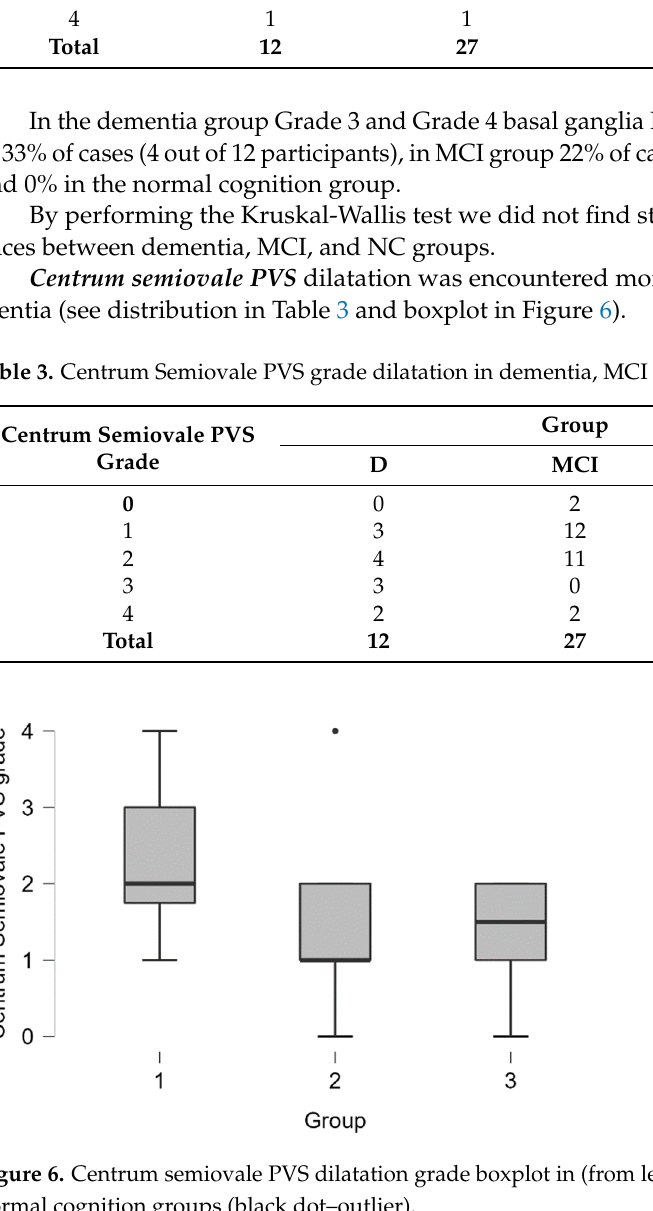
Table 4. Dunn post-Hoc comparison of Centrum semiovale PVS between D–MCI, D–NC, and MCI– NC groups. Comparison